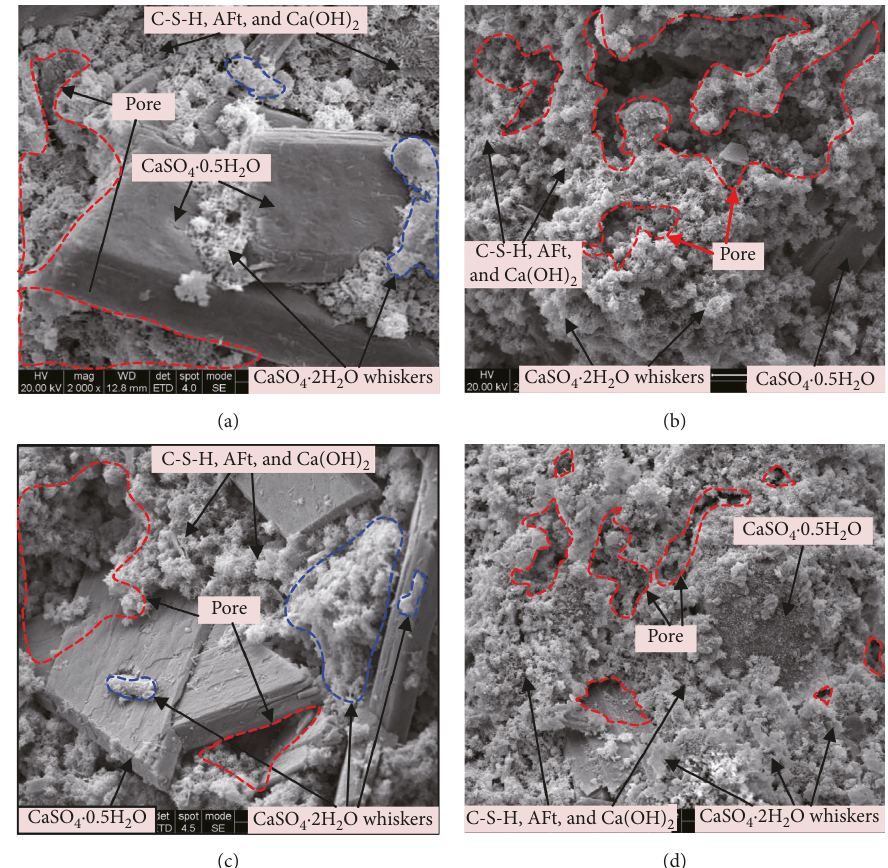
Figure 9: SEM images of specimens of backfill body. (a) S22 cured for 7 days; (b) S22 cured for 28 days; (c) S23 cured for 7 days; (d) S23 cured for 28